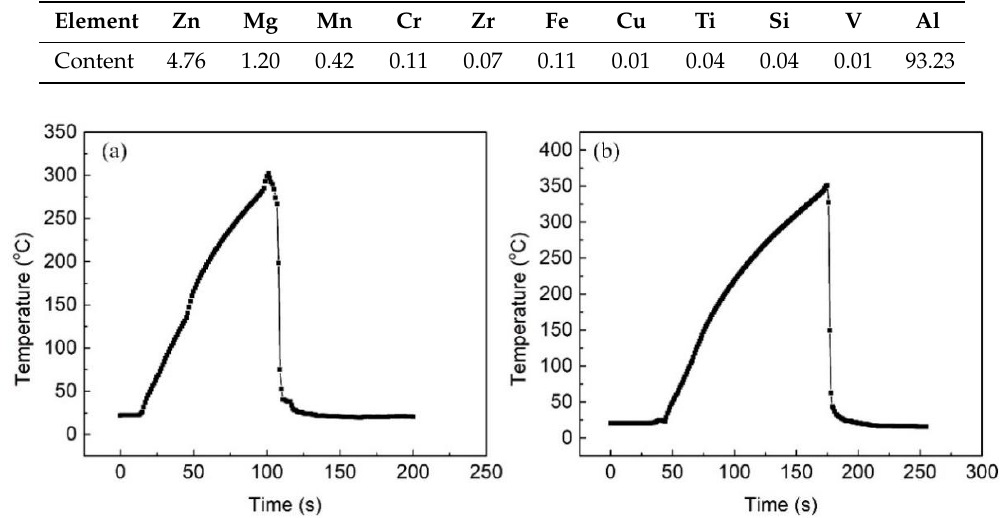
Table 1. Chemical composition of 7N01 aluminum alloy (wt.%).